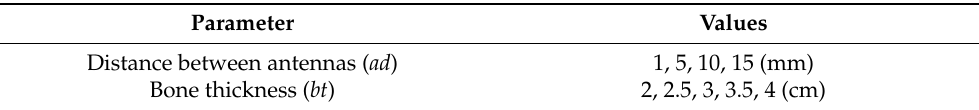
Table 2. Parameters included in the parametric